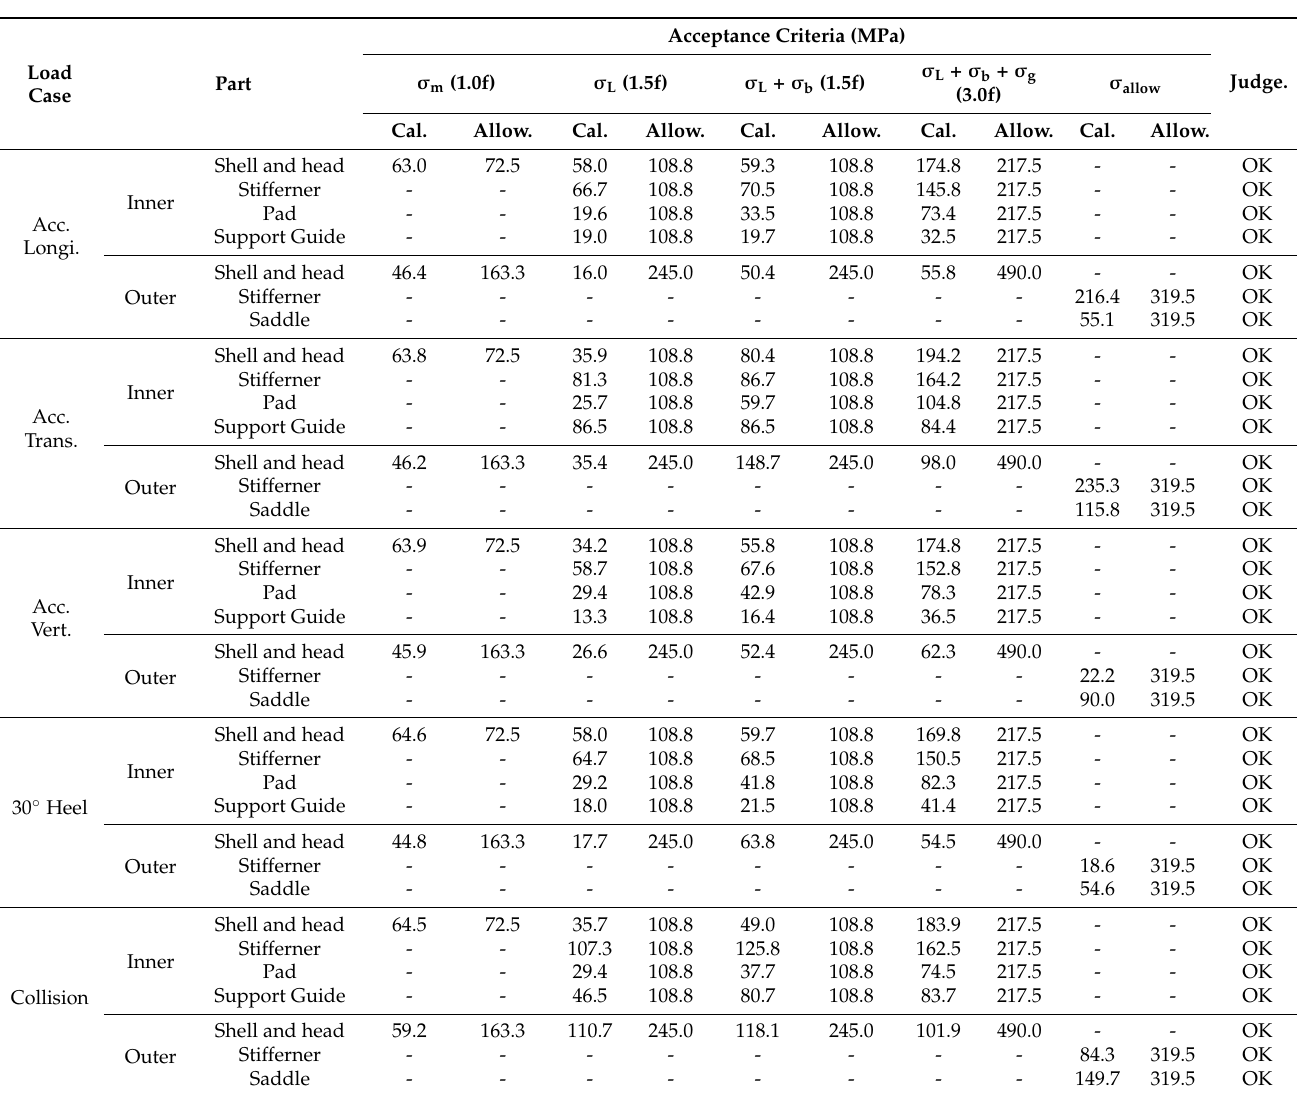
Table A3. Summary of structural analysis result for